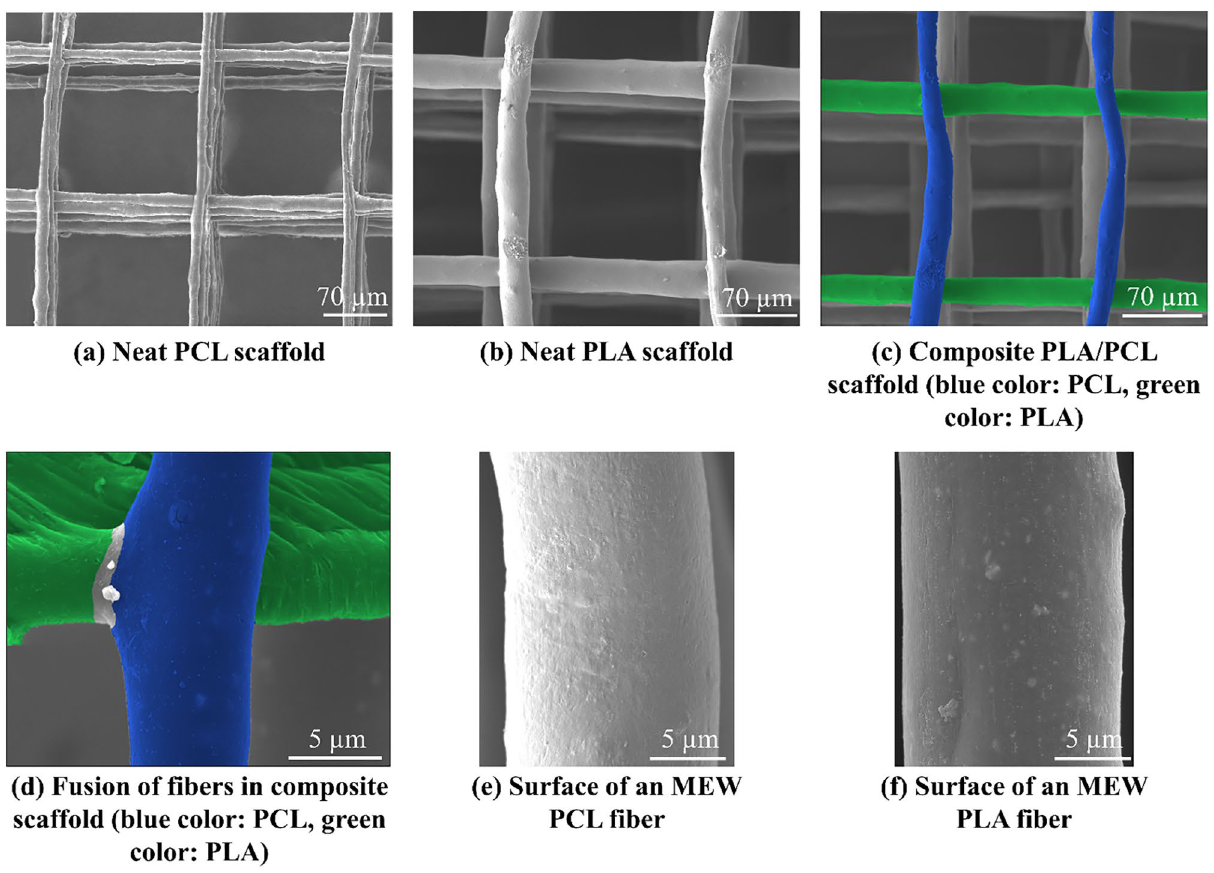
Figure 4. SEM images of the melt elecrowritten scaffolds, ( a–c ) well-ordered box structure of the neat PCL, neat PLA, and composite PLA/PCL scaffolds, respectively, ( d ) bonding and connection of two fibers (the below one is PLA and the upper one is PCL) melt electrowritten in two consecutive layers perpendicularly on each other, and ( e,f ) surface of one of the PCL and PLA fibers, has just one nozzle head, when fabrication of one layer of the composite scaffold with for example PLA filament is finished, one should stop the FDM device and wait for the temperature of the filament to decrease. When the temperature of the PLA filament reaches to that of the room, it is drawn out of the guide tube and after becom- ing sure that the print path starting from the gear system to the nozzle head is clear and open, the PCL filament is placed between the gears of the gear system and the MEW process is begun. The same process is repeated when the PCL filament should be replaced with the PLA filament. Therefore, for one composite scaffold to be completely printed, the process of changing and replacing the filaments should be conducted nine times. In this study, the aim was to investigate the effect of different materials on the properties of the melt electrow- ritten scaffolds. Since geometrical characteristics like pore size affect the cell-scaffold interactions, the scaffolds should have similar geometry. Therefore, the printing parameters are set to obtain scaffolds with approximately equal pore sizes in the range of 140 µm to 160 µm. It should be noted that difficulties in MEW process of PLA fibers make it nearly impossible to fabricate scaffolds having smaller pore sizes. In the case of fiber diameters, PCL fibers are mostly narrower (with diameters in the range of 5 µm to 15 µm) than PLA fibers (with diameters between 15 and 25 µm). Bakirci et al. 54 stated that the viscosity of a polymer melt is the parameter affecting the